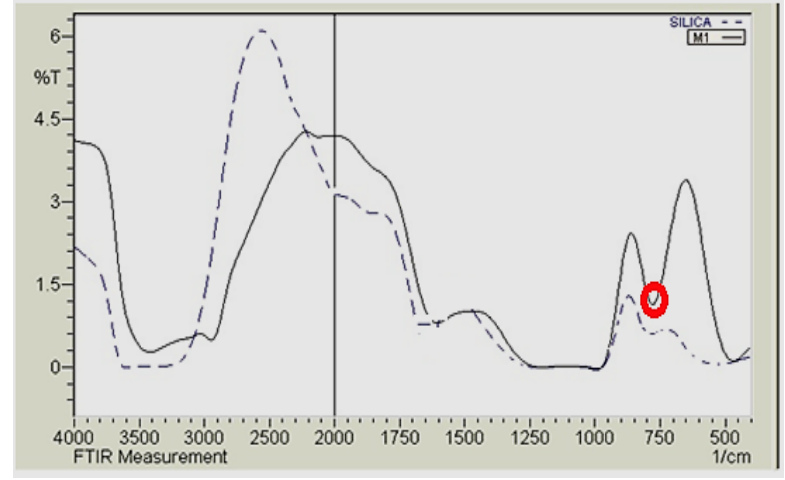
Figure 3. FTIR for amine-functionalized (dashed line) and magnetic immobilized functionalized (straight line) silica gel.